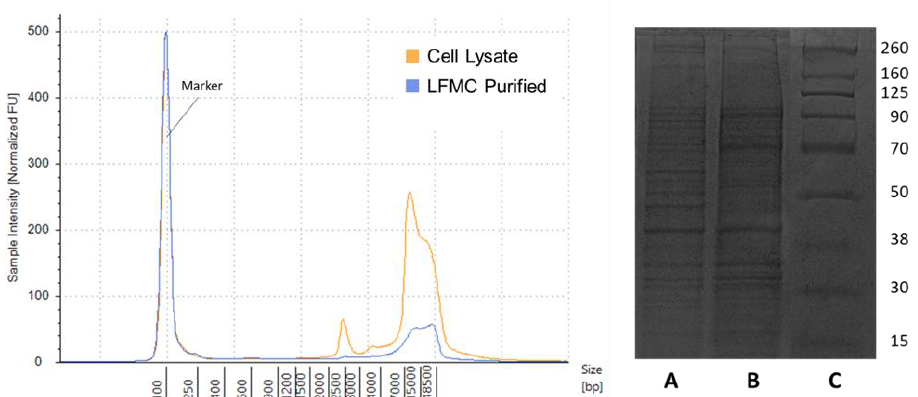
Figure 2. Analysis of the size distribution of purified fractions of host cell DNA and host cell protein (from AEX chromatography) obtained from Vero cells. ( Left ) Electropherogram from Agilent TapeStation analysis of strand length of host cell DNA from the crude cell lysate and from the cell lysate purified using anion exchange (AEX) chromatography (identified as Peak 4 in Figure S3). ( Right ) Image from SDS PAGE analysis of host cell protein from the crude cell lysate (Lane A); the host cell protein purified using AEX chromatography, which is identified as Peak 2 in Figure S3 (Lane B); and Chameleon Duo pre-stained protein ladder (Lane C). The original electropherogram and gel image are available in Supplementary Material as Figure S4.